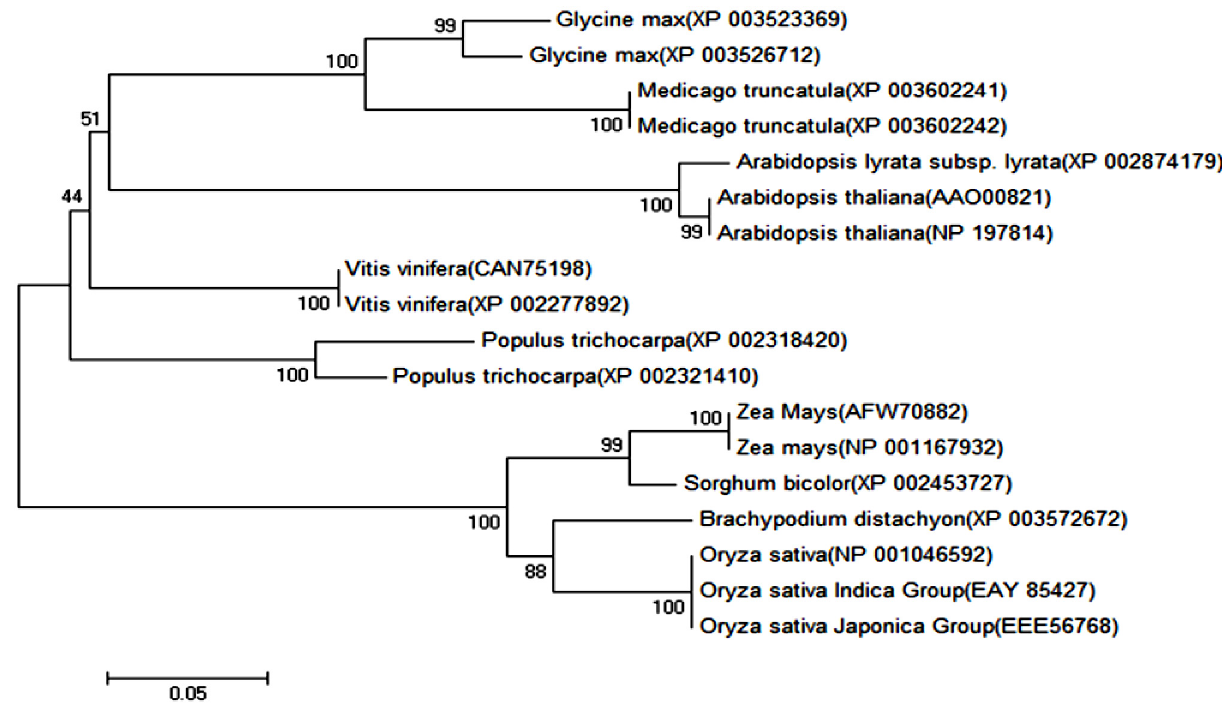
Figure 2. The phylogenetic analysis of prolyl oligopeptidase from rice and other plant species by MEGA 5.05 from CLUSTAL W alignments. The neighbor-joining method was used to construct the tree with p-distance. The number for each interior branch is percent bootstrap value (100